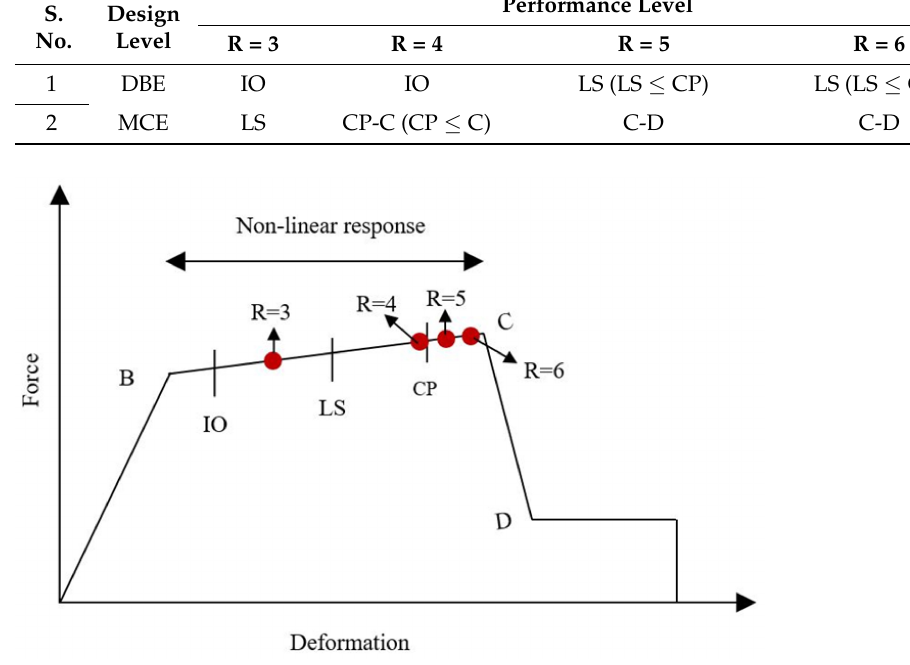
Figure 10. Schematic representation of variation in the building performance level with respect to R factors at the MCE design level under unidirectional loading.